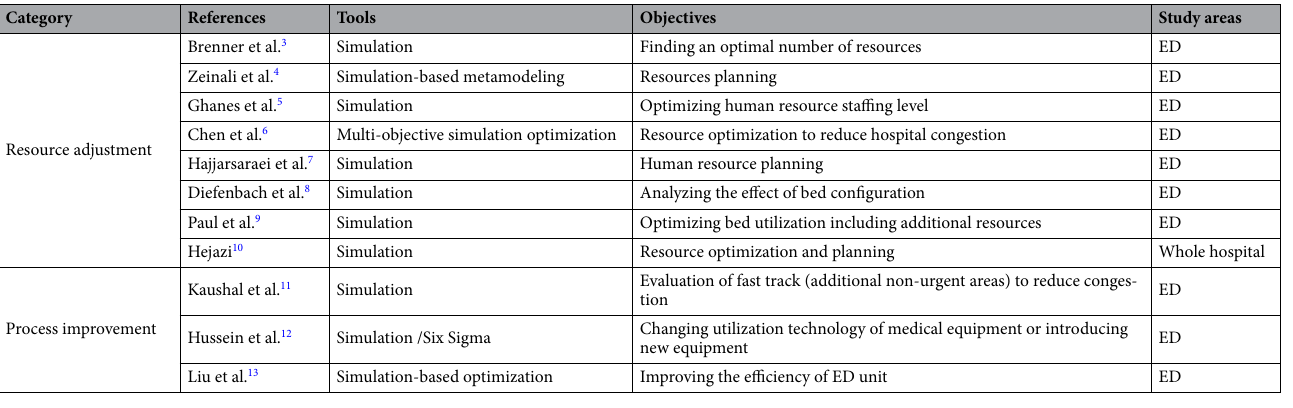
Table 1. A summary and comparative review of the major works in the literature. ED, emergency